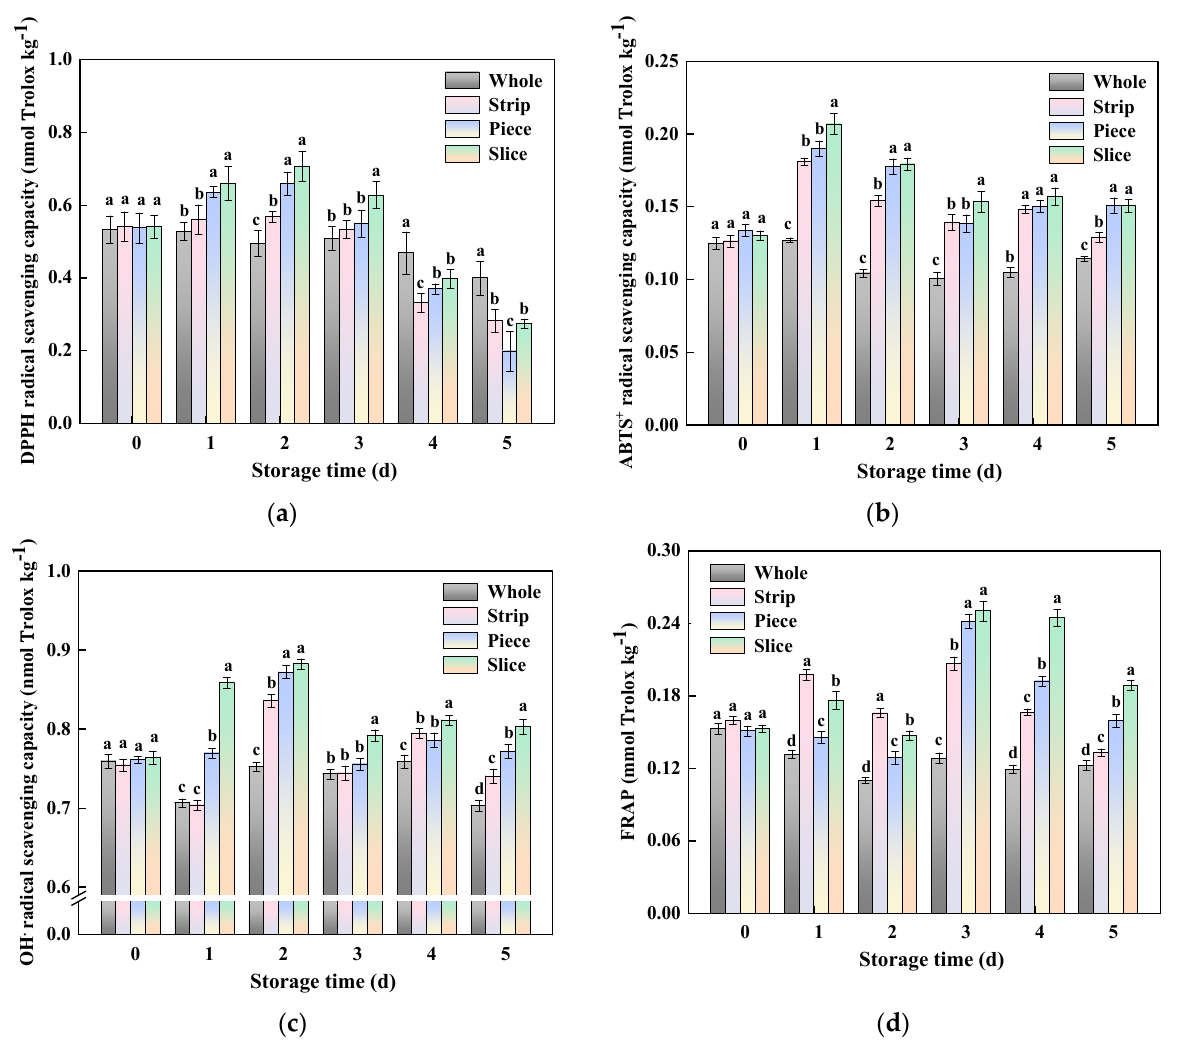
Figure 7. Effect of cutting methods on DPPH radical scavenging capacity ( a ), ABTS + radical scavenging capacity ( b ), OH· radical scavenging capacity ( c ), and ferric − reducing antioxidant power (FRAP) ( d ) in fresh − cut cucumbers. Vertical bars represent the standard deviation of the mean (n = 3). Different letters indicate significant differences between the groups ( p < 0.05).